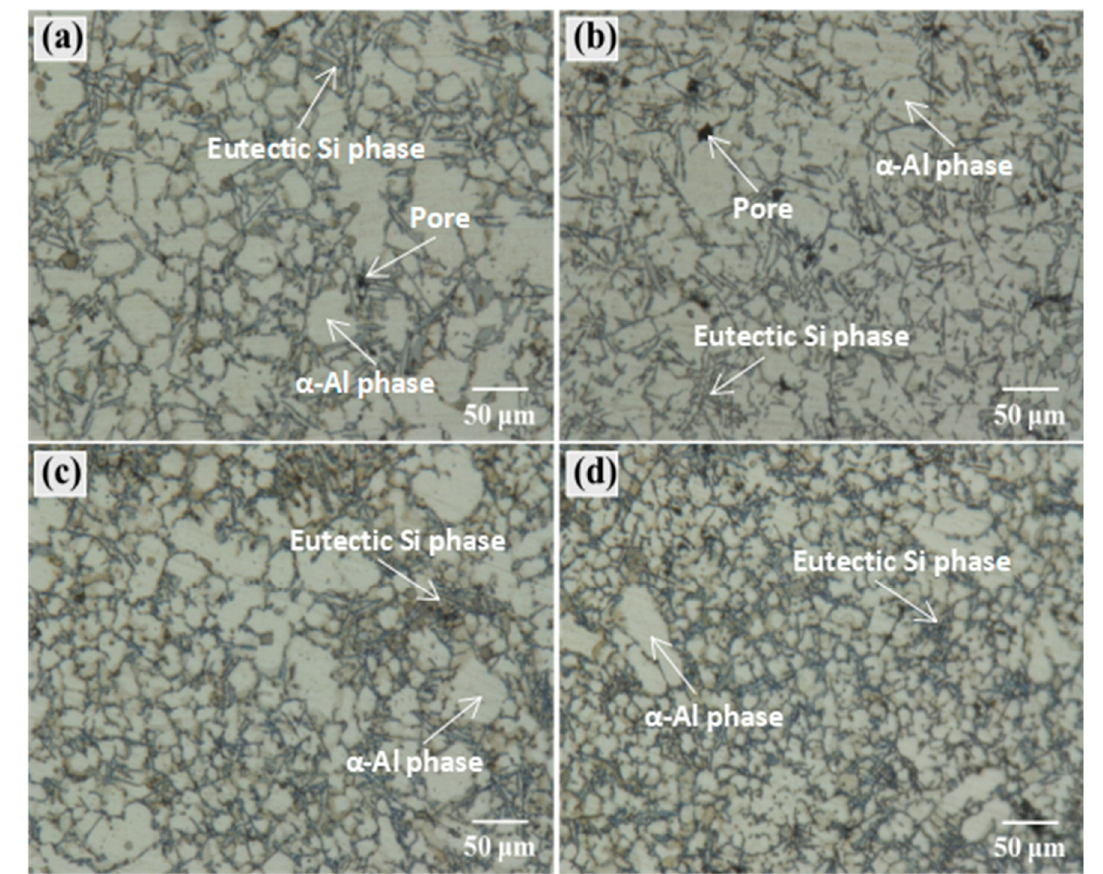
Figure 10. Microstructure of thick-walled area at different boost pressures: ( a ) 700 bar, ( b ) 750 bar, ( c ) 800 bar, ( d ) 850 bar.